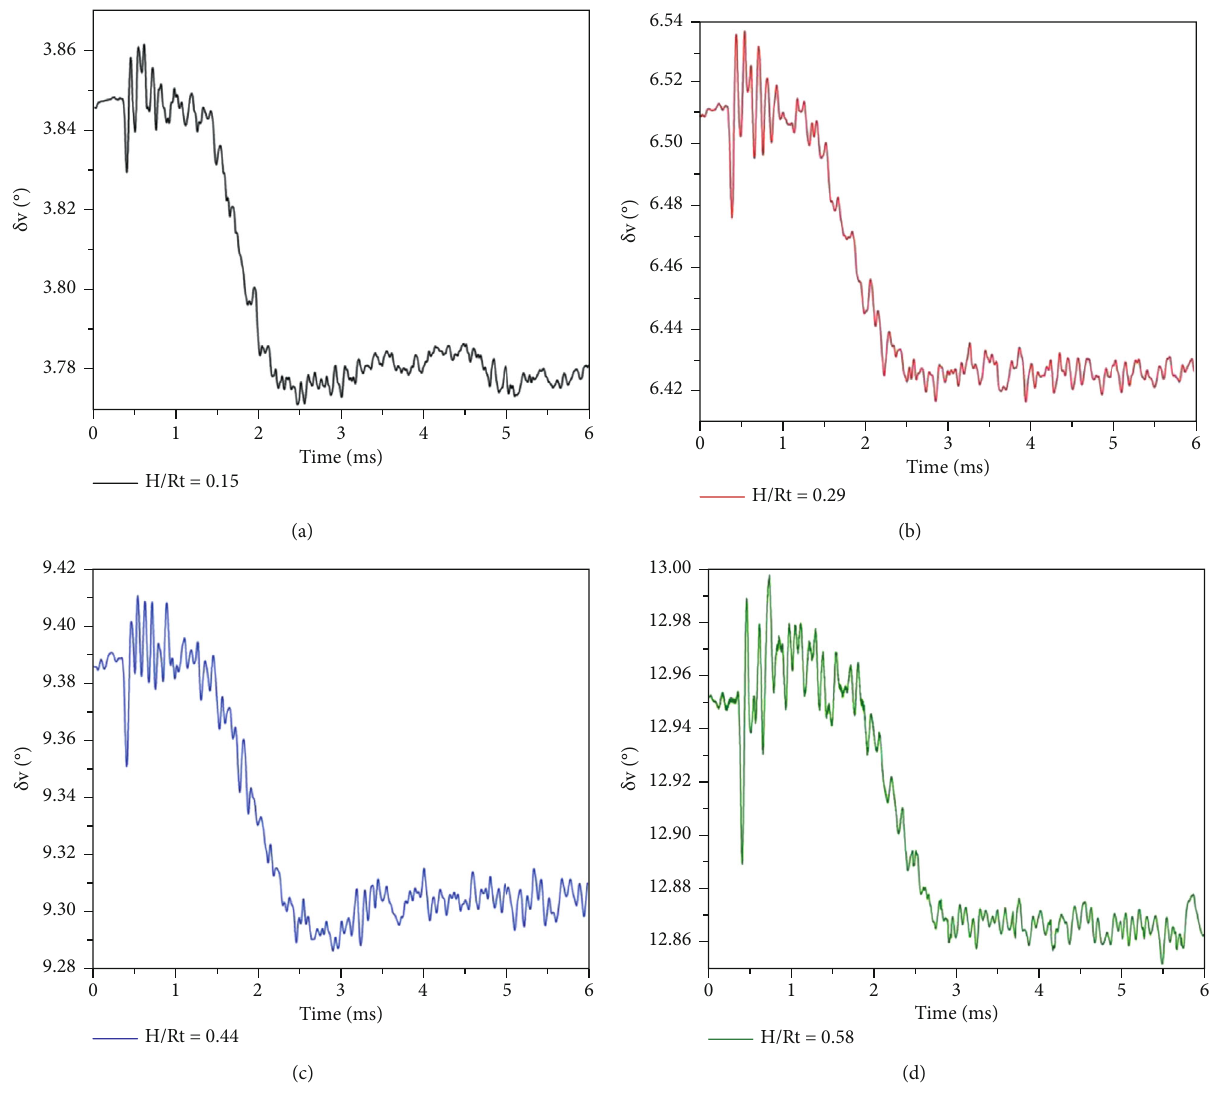
Figure 18: Vectoring angle oscillations for di ff erent rod penetration heights ( NPR = 4 : 6 and X = 0 : 44 ; (d) H / R (c) H / R t